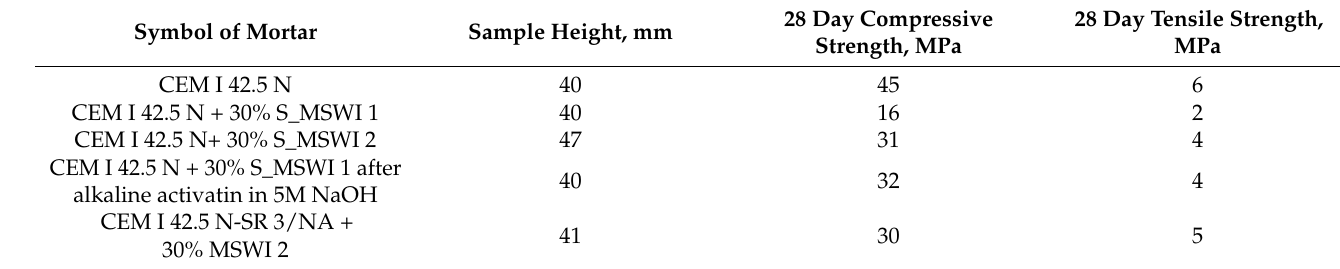
Table 9. The test results of mechanical properties of the